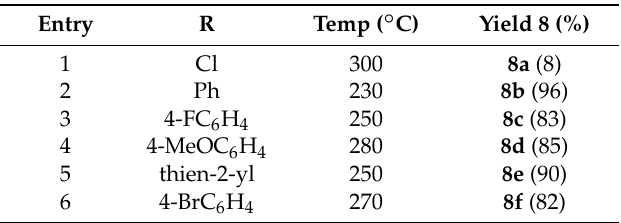
Table 1. Thermolysis of neat 4,4 ′‐ disubstitued 5,5 ′‐ bi(1,2,3 ‐ dithiazolylidenes) 11a – f (0.10 mmol) for